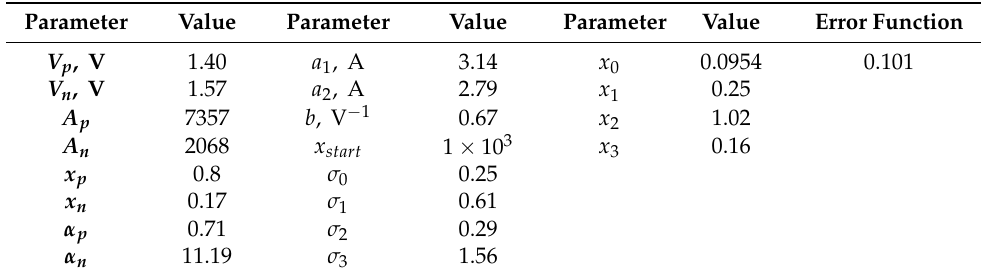
Table 5. Optimal parameters of the model obtained by sequential use of the machine learning model and optimization